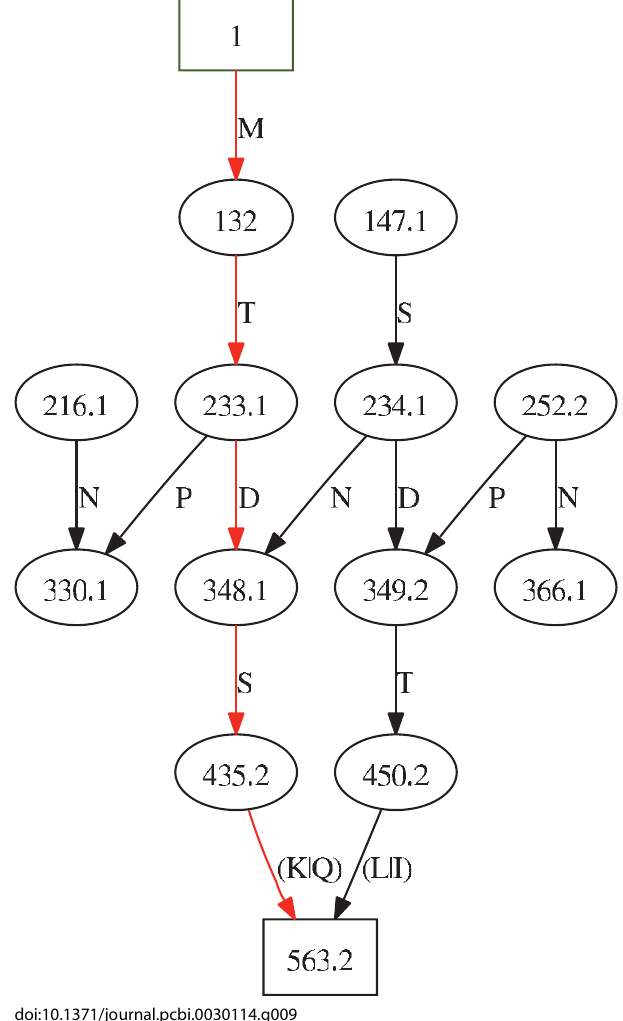
Figure 9. Spectrum Graph Spectrum graph of peptide MTDSK. The spectrum contains the b and y fragment ion masses plus two neutral losses and two peaks generated from noise. Only one amino acid’s mass differences are accepted. Masses are complemented and interpreted as b fragments. Even in this oversimplified case, it is observed that many edges are created in addition to those that are necessary. In particular, part of the reverse sequence in the graph is observed. The graph complexity increases rapidly with real spectra and with two amino acid mass differences accepted; see also the two examples given in Figures S1 and